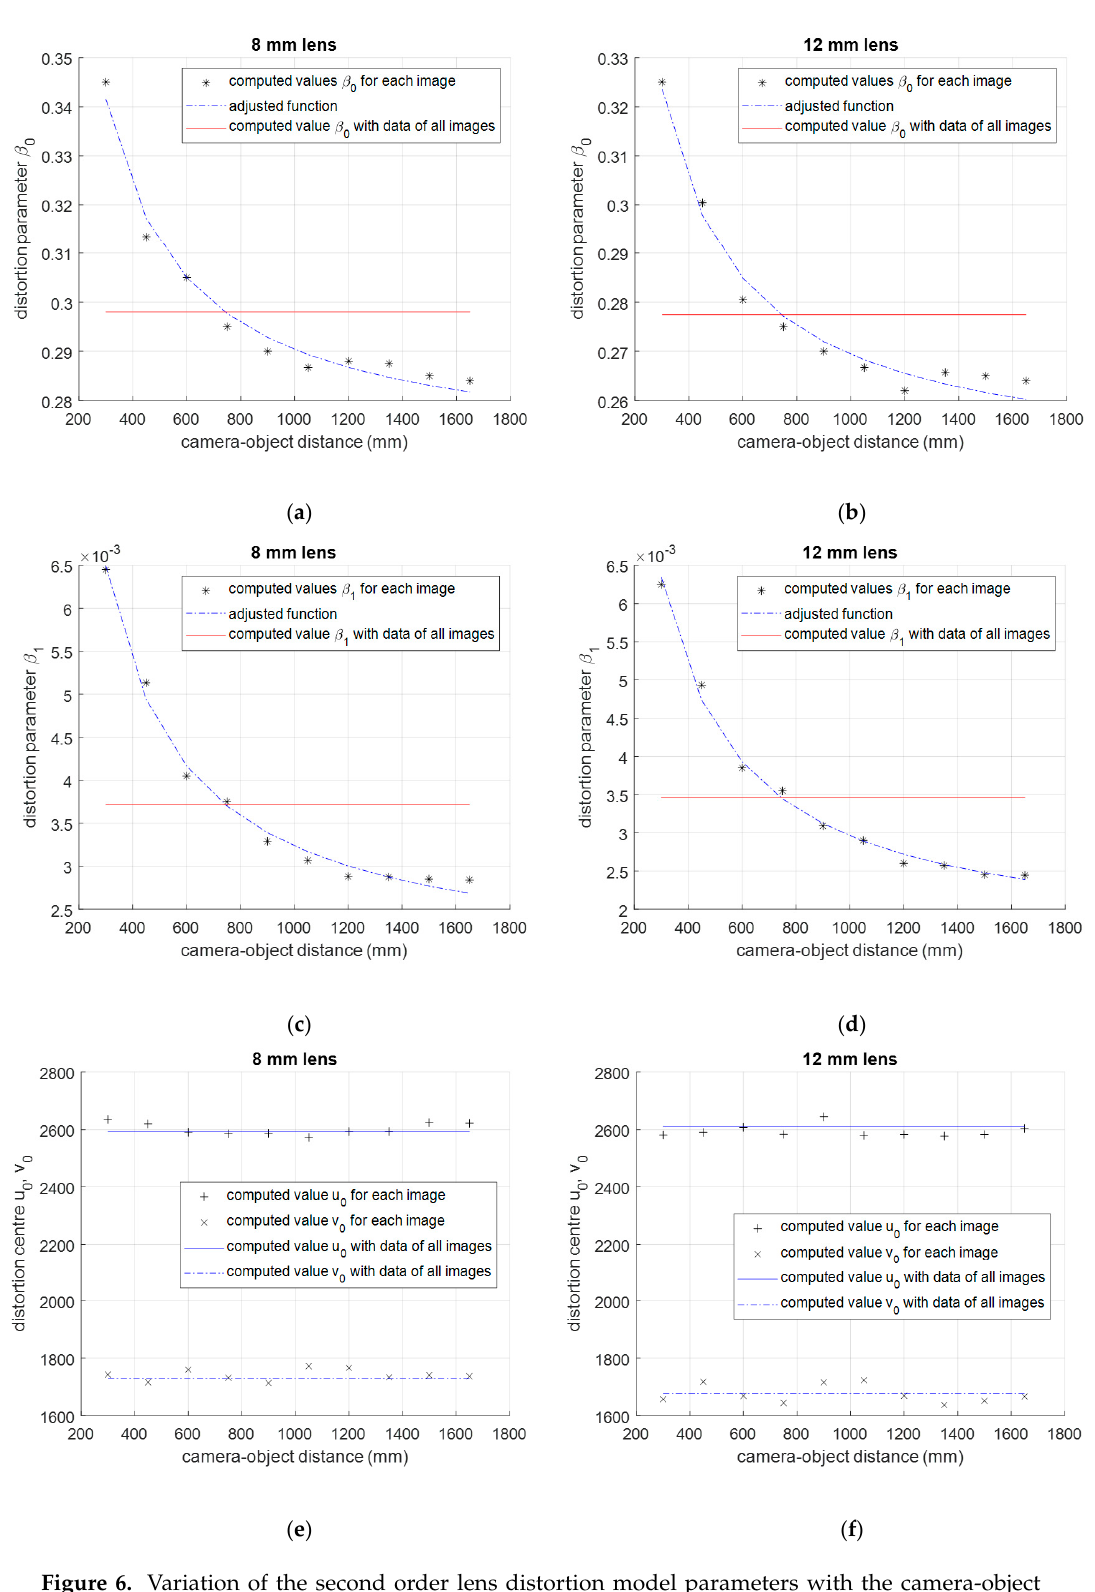
Figure 6. Variation of the second order lens distortion model parameters with the camera-object distance. The computed parameters are β 0 , β 1 and distortion center u 0 , v 0 . The asterisks show the computed value of the parameter for each image and the dashed line shows the value given by the function β 0 ( d ), β 1 ( d ) adjusted using the least squares technique with asterisk data, β 0i and β 1i . ( a )( c )( e ) is for 8 mm lens and ( b )( d )( f ) is for 12 mm lens.